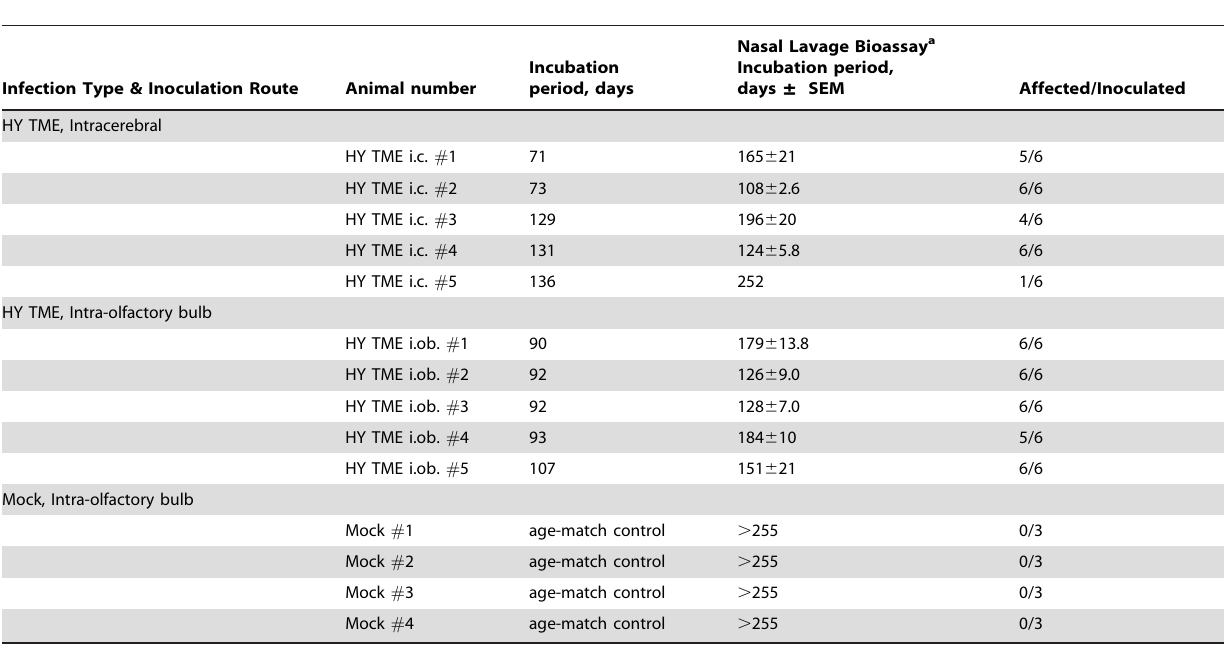
Table 3. Prion infectivity in nasal lavages of HY TME infected